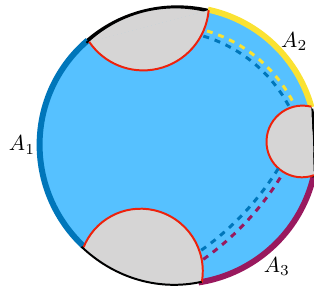
Figure 15 . Σ when it obtains its upper bound is built from bipartite entanglement wedge cross